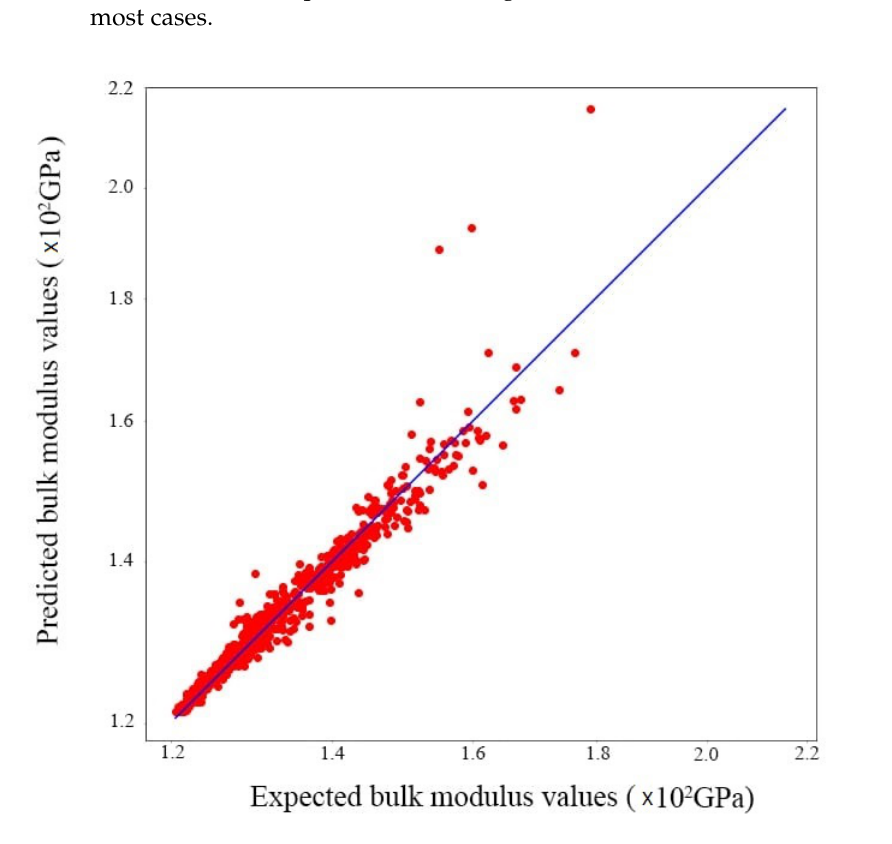
Figure 11. Convolutional predictions for the bulk